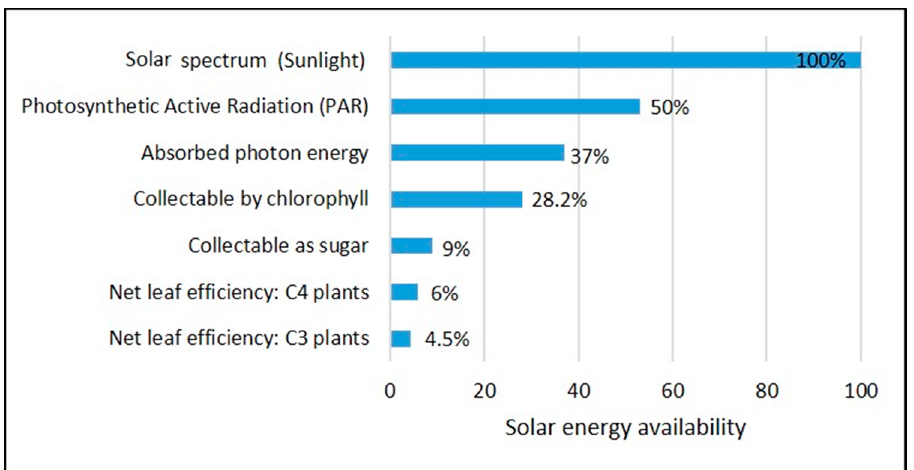
Figure 4. Stepwise energy loss during photosynthesis.